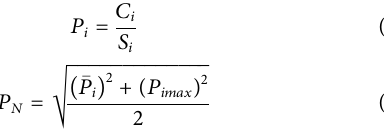
FIGURE 1 The XRD patterns of the low-grade copper sul fi de